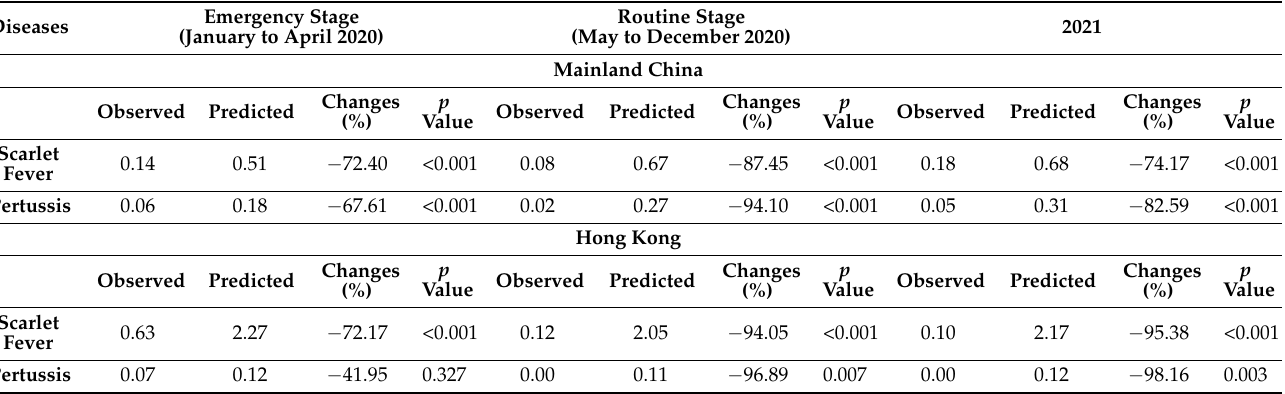
Figure 7. Prediction of the monthly incidence rates (1/100,000) of scarlet fever and pertussis from 2020 to 2021. ( a ) Prediction of incidence in Mainland China; ( b ) prediction of incidence in Hong Kong. Red lines mean fitted and predicted lines; light green lines mean observed ones. The predicted monthly incidences from 2020 to 2021 were generated using ARIMA based on the corresponding values during the period 2004–2019. Table 3. Changes in the monthly incidences (1/100,000) of scarlet fever and pertussis between the observed and predicted values from 2020 – 2021.